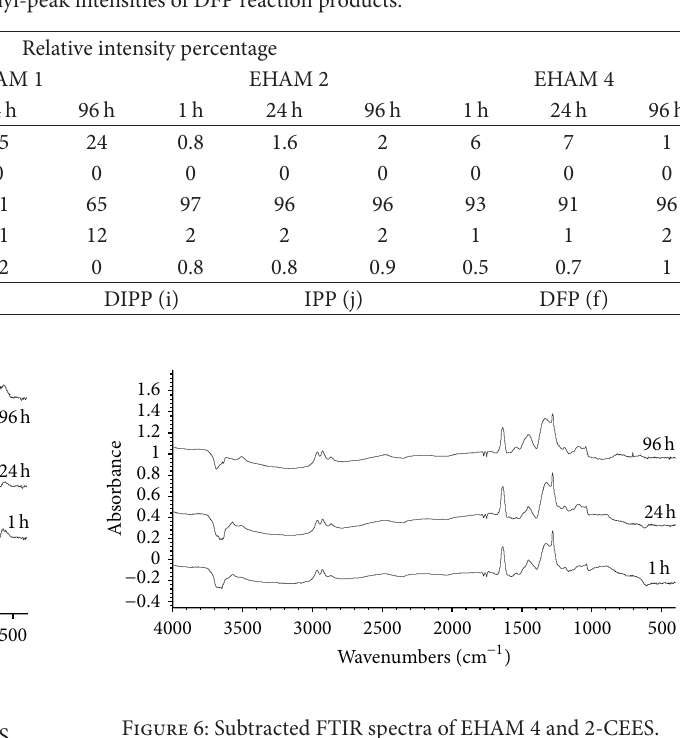
T 6: Comparison of methyl-peak intensities of DFP reaction products.